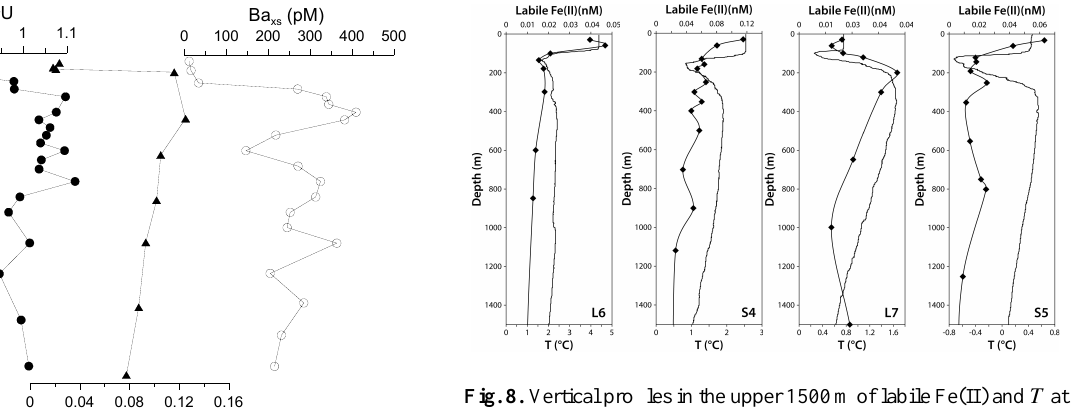
Fig. 8. Vertical profiles in the upper 1500m of labile Fe(II) and T at the 4 stations south of the PF where the AAWW were clearly